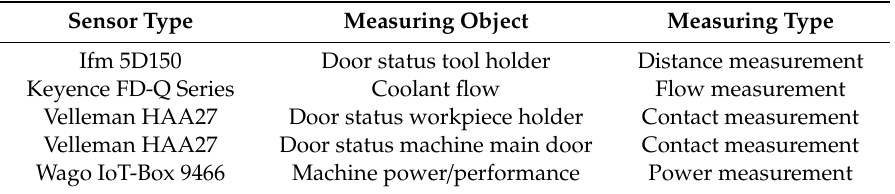
Table 10. All of the sensors used to generate machine